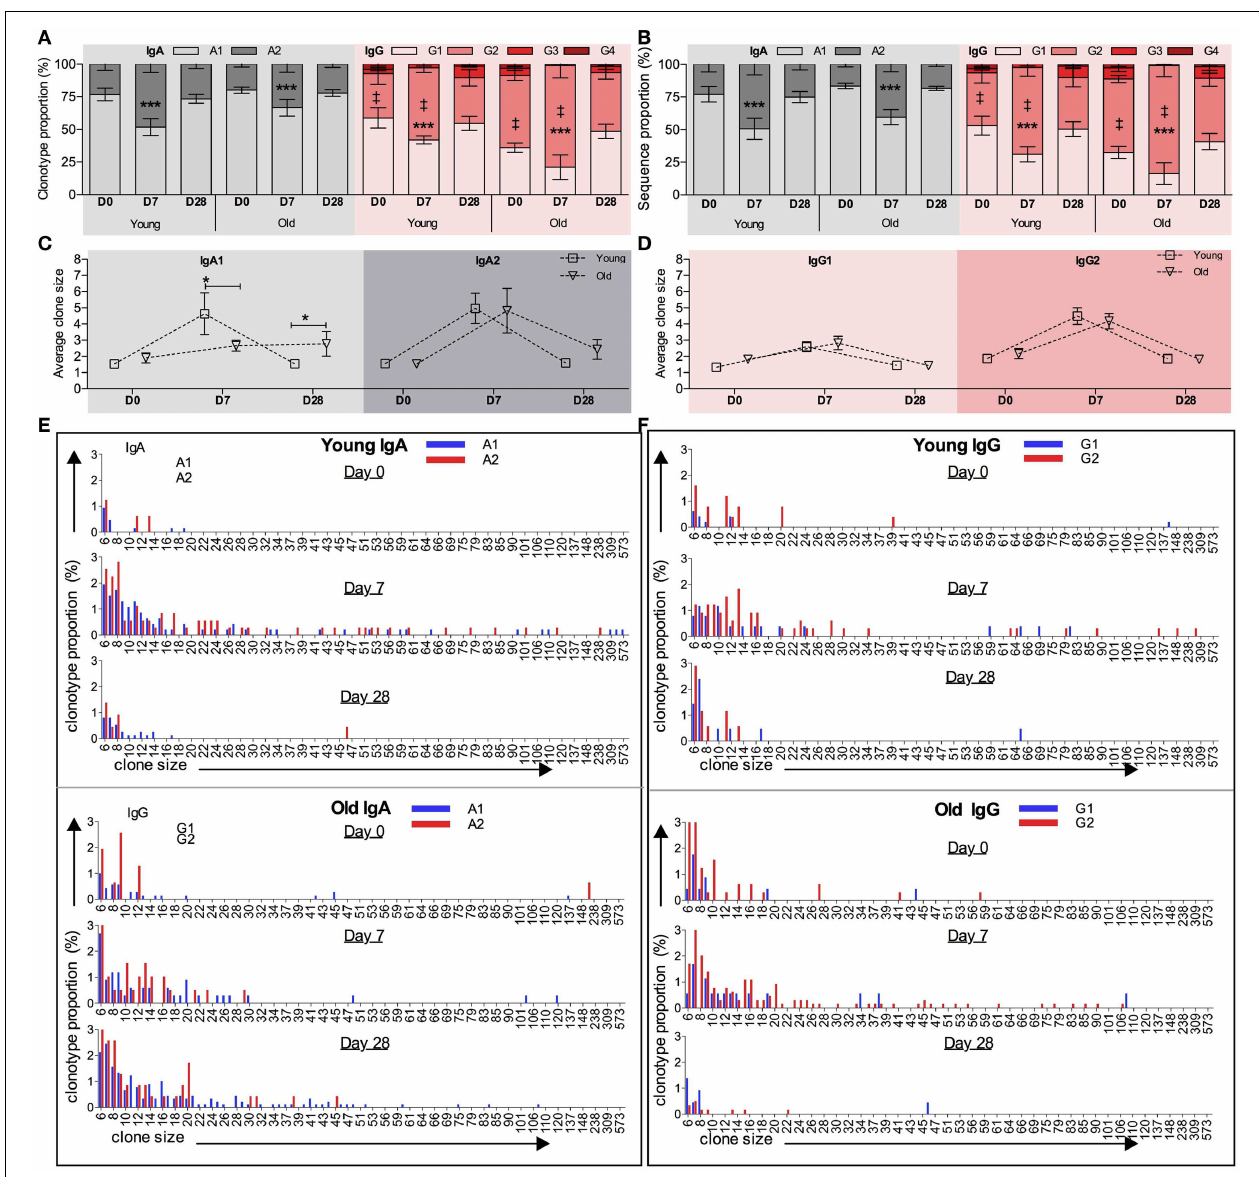
size ( y -axis) of IgA1 and IgA2 clonotypes (C) and IgG1 and IgG2 clonotypes (D) was calculated to be the ratio of total sequences over total clonotypes for each donor individually, before being compared between young versus old ages (* p < 0.05; one-way ANOVA comparison). Bars indicate ± SEM. Clonotypes of (E) IgA subclasses (IgA1: blue bars and IgA2: red bars) and (F) IgG subclasses (IgG1: blue bars and IgG2: red bars) were grouped by their clone sizes ( x -axis), and the proportion of each groups ( y -axis) was calculated at D0, D7, and D28. Clones containing fewer than five sequences are not